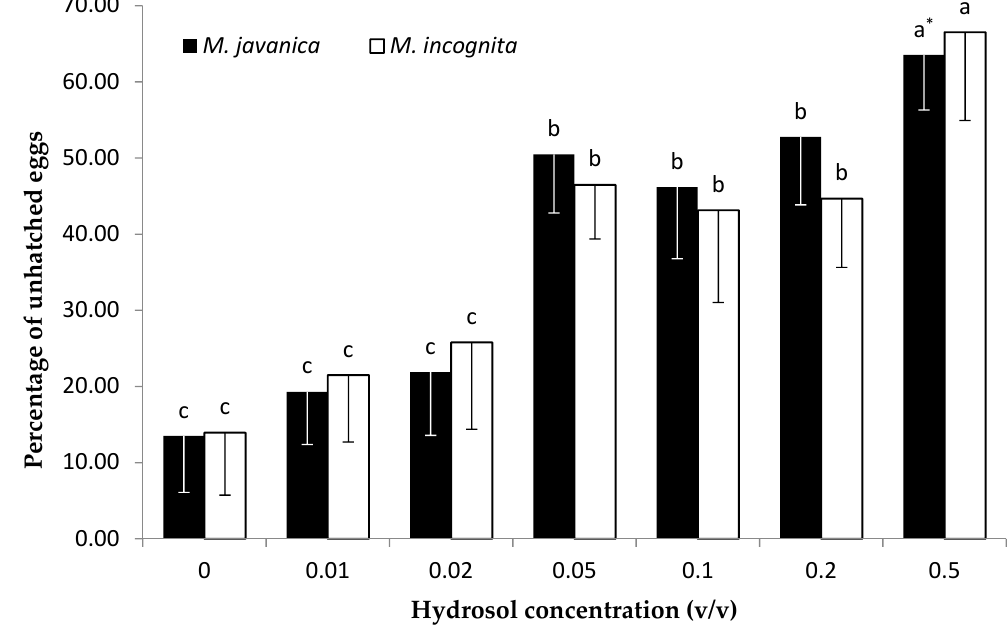
Figure 6. Effect of Cuminum cyminum seeds hydrosol on hatching of M. javanica and M. javanica J2s after immersion in test solutions at concentrations of 0, 0.01, 0.02, 0.05, 0.1, 0.2, and 0.5 v/v for 28 days. * Bars with the same color followed by the same letter are not significantly different according to Tukey’s HSD test at p < 0.05.